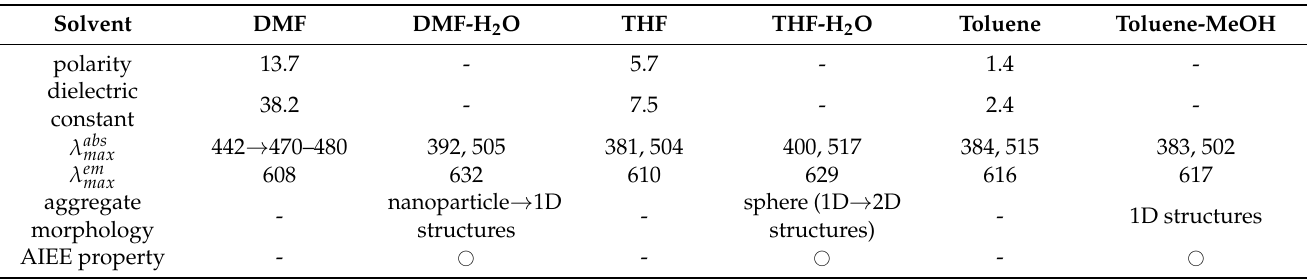
Figure 1. Normalized UV-vis absorption spectra for 3Bu ( a ) in solvents with different polarities and ( c ) in mixed solutions. ( b ) Absorption spectra of 3Bu toluene solutions measured in concentration range from 0.29 to 29 µ M. ( d ) Photograph of 3Bu in (i) DMF (5 µ M), (ii) DMF (20 µ M), (iv) toluene, and (v) DMF-H 2 O mixture. All solutions except for DMF in ( a ) and toluene in ( b ) had a concentration of 10 µ M. See Table 1, also. Table 1. Solvent properties, spectroscopic data, and self-assembled structures of 3Bu obtained from various solvent environments.